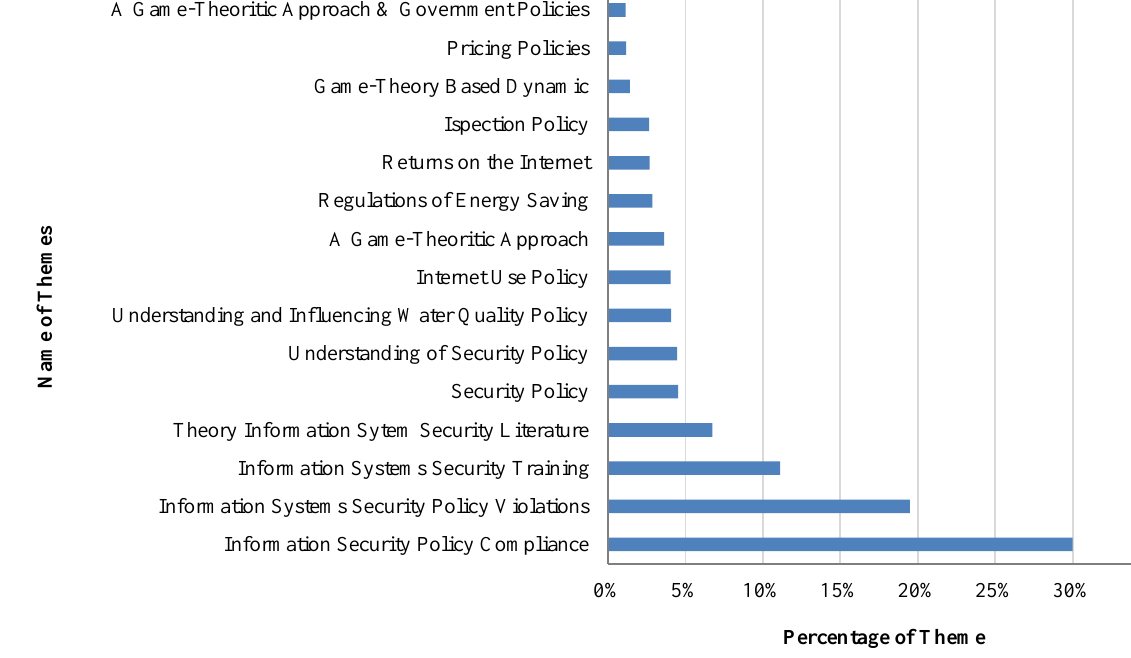
Figure 4. Frequently occurring themes in theories related to policy